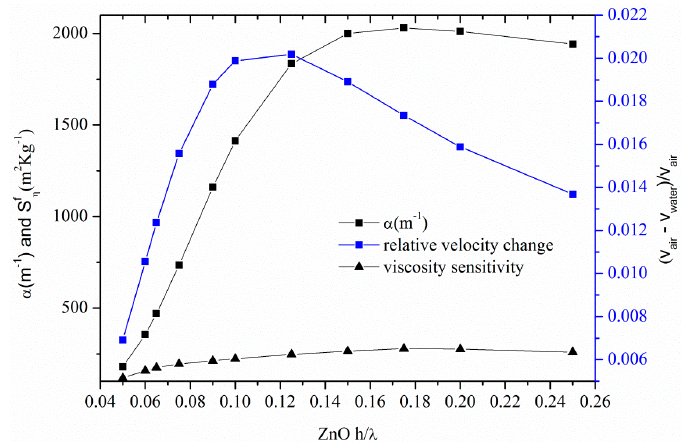
Figure 11. The attenuation α and the relative velocity changes due to the presence of the viscous liquids.